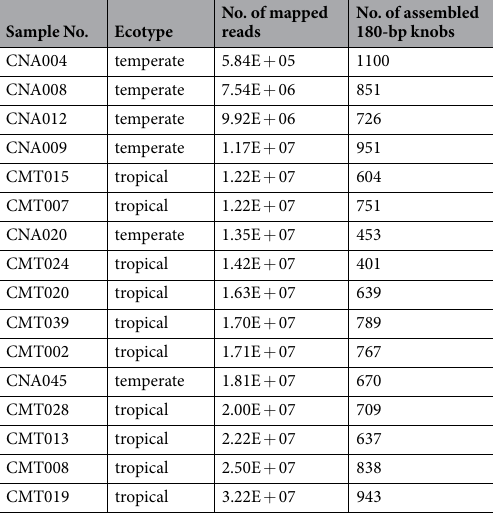
Table 1. The number of reads mapped to 180-bp knobs and the number of assembled 180-bp knob sequences for 16 resequenced maize inbred lines.